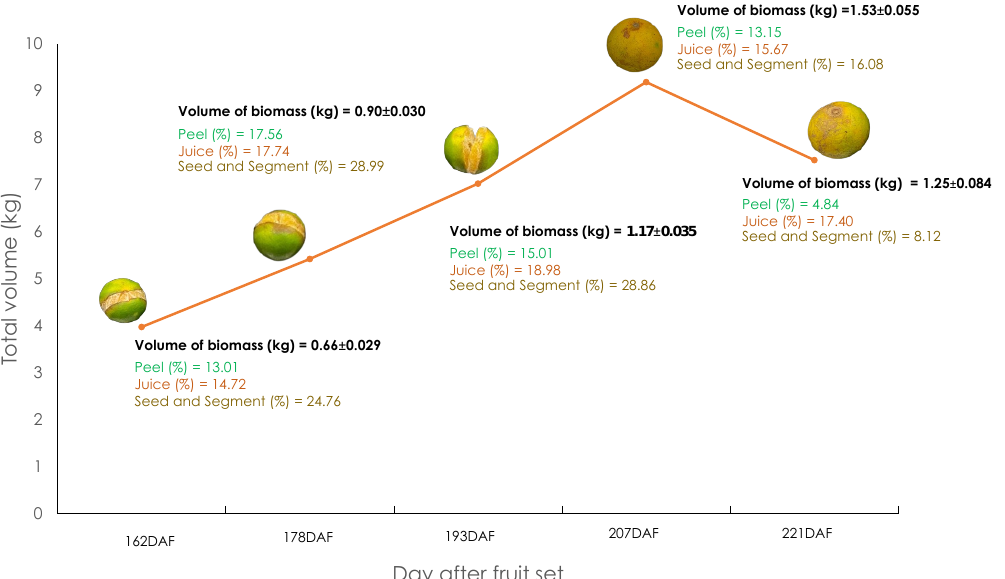
Figure 2. The average volume of biomass and percentages of each biomass type (peel, juice, and seed and segment). Data were collected from October to November 2021 from 6 plots (each containing 3 plants).